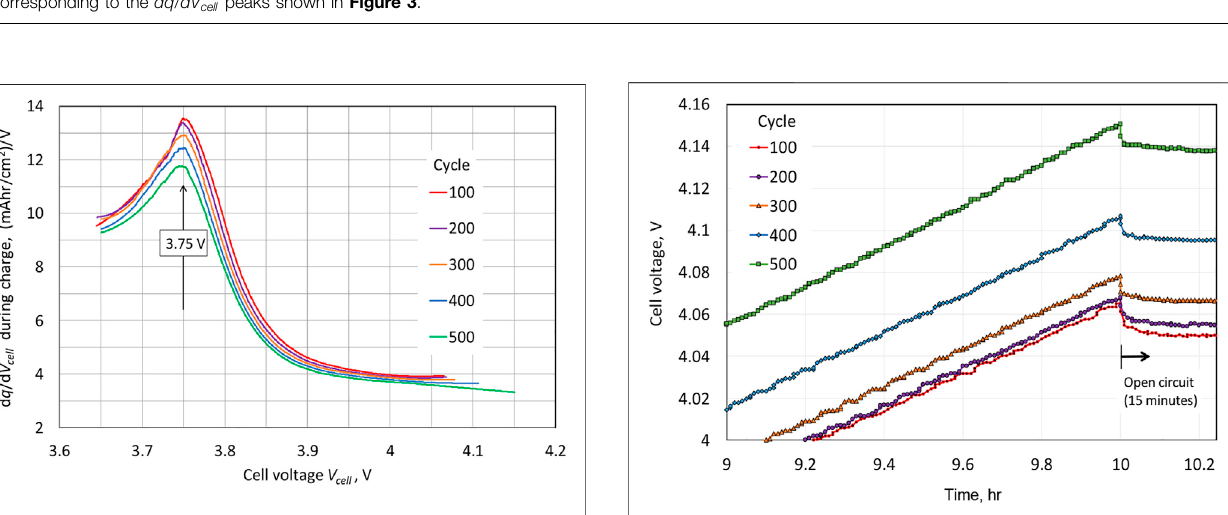
FIGURE 3 | The dq / dV cell vs. V cell curves were generated from the data shown in Figure 2 . FIGURE 4 | The abscissa of Figure 2 is expanded about the transition